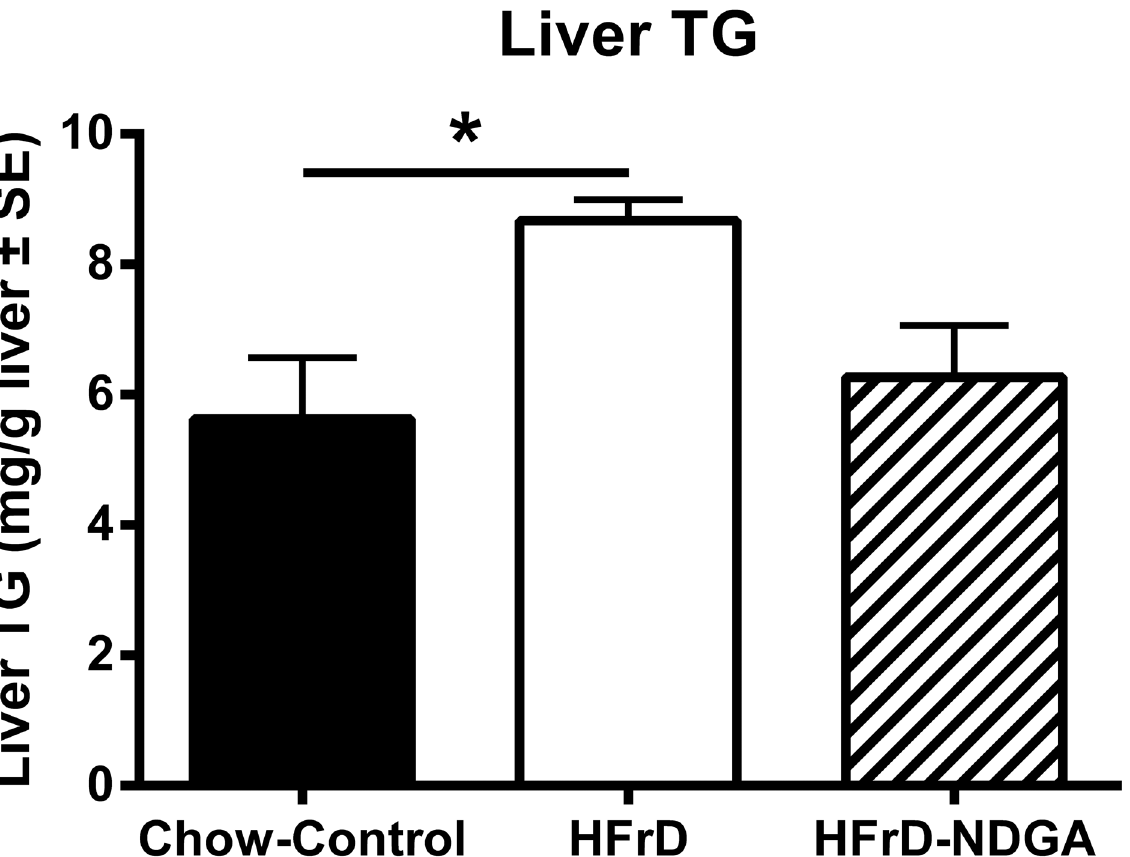
Fig 1. Effect of orally administered NDGA on liver weights (A) and triglyceride content (B) in high-fructose fed (HFrD) hypertriglyceridemic rats. Groups of rats were maintained on a chow-diet (n = 4) or HFrD (n = 12) for 8 weeks and, subsequently, HFrD fed rats were divided into two groups: one was orally gavaged with NDGA (n = 6) at a dose of 125 mg/kg BW twice a day for 5 days and the other group received vehicle (n = 6) (control). Liver samples were subsequently weighed (A) and quantified for TG content (B), as described in the Materials and Methods. Values are mean ± SE. * P < 0.05; ** P < 0 . 01 ; *** P < 0 . 001 . Raw data and statistics are listed in S1 Dataset.